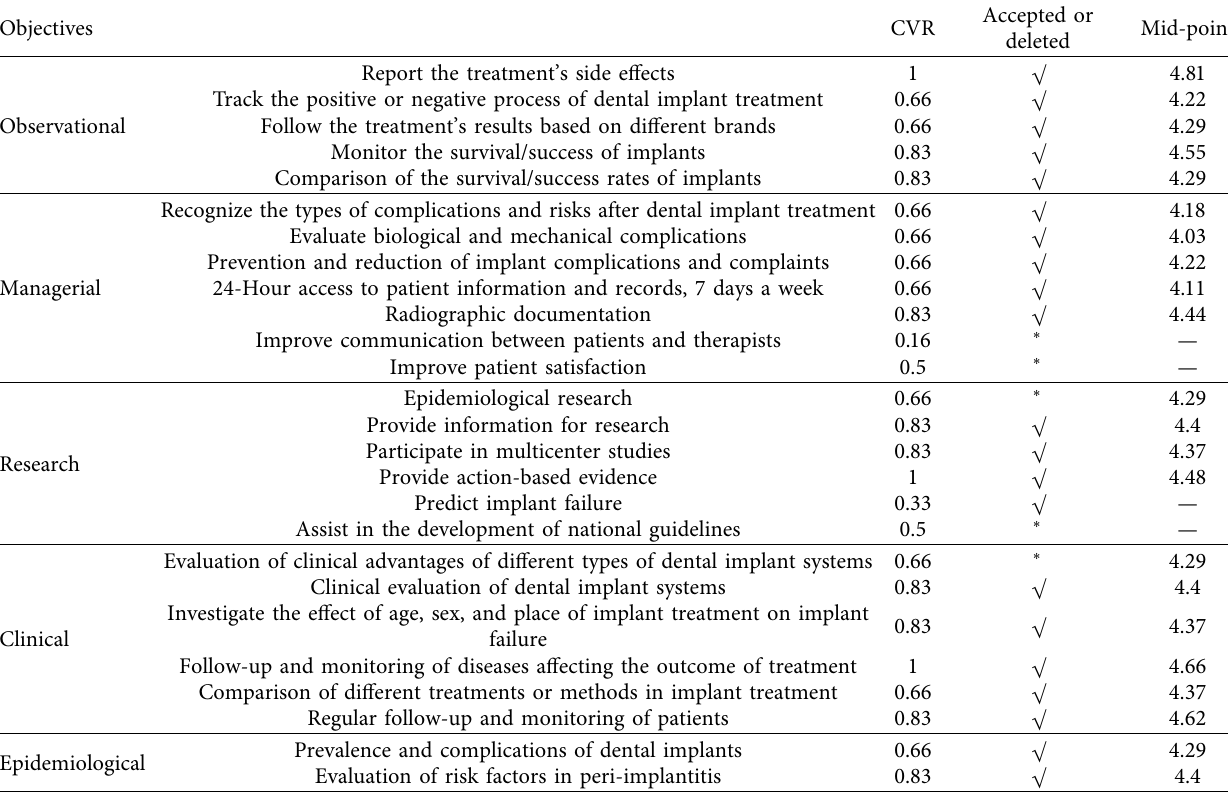
Table 1: Objectives of DIR along with CVR and midpoint values.